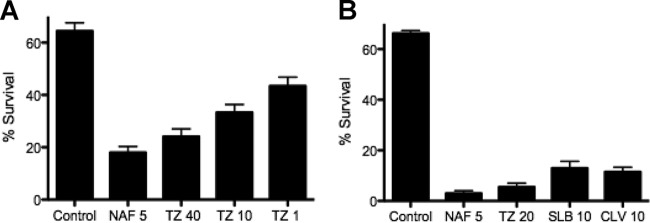
(A) LL37 killing assays displaying 2-h survival of VISA strain D712 (LL37 at 128 μM) after growth overnight in antibiotic-free medium (control) or in medium containing nafcillin (NAF) or tazobactam (TZ) at the indicated concentrations (milligrams per liter). (B) Similar experiment with hVISA D592 utilizing LL37 at 64 μM and nafcillin, tazobactam, SLB, or clavulanic acid (CLV).